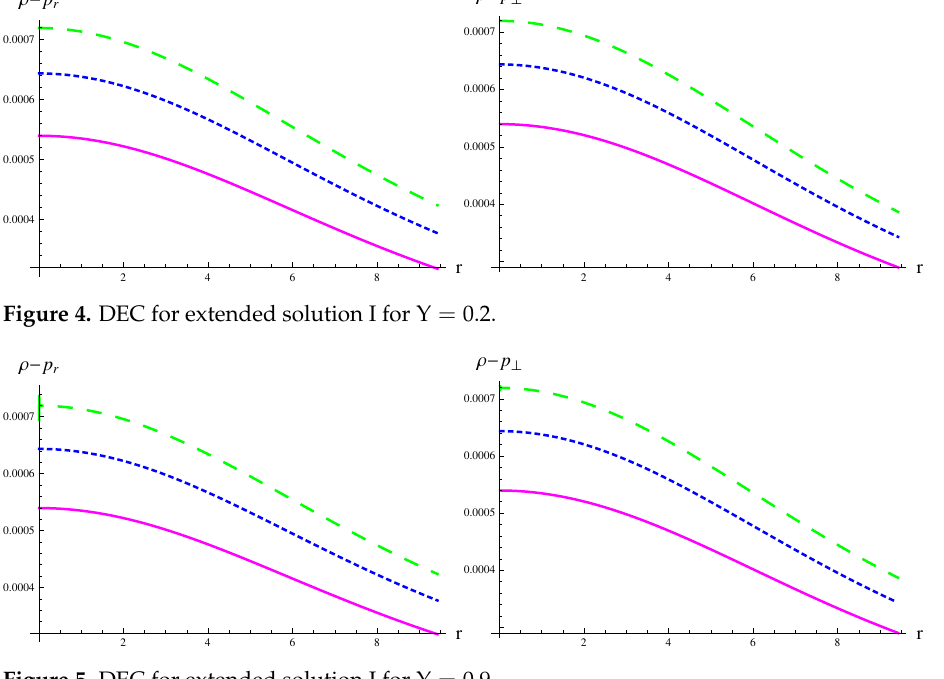
Figure 5. DEC for extended solution I for Υ =